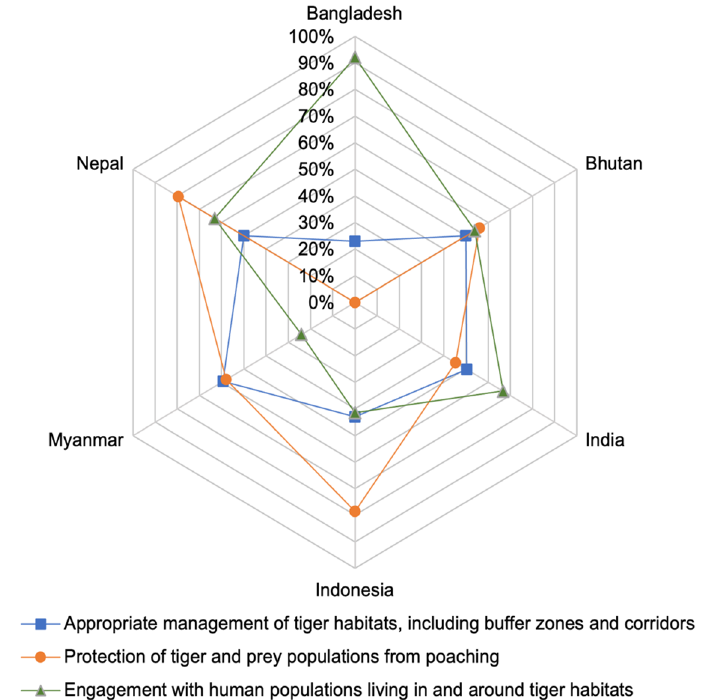
Figure 4. Average per country of the extent to which the proposals of their ITHCP project(s) address the actions stated in their corresponding NTAPs that match with the ITHCP pillars.